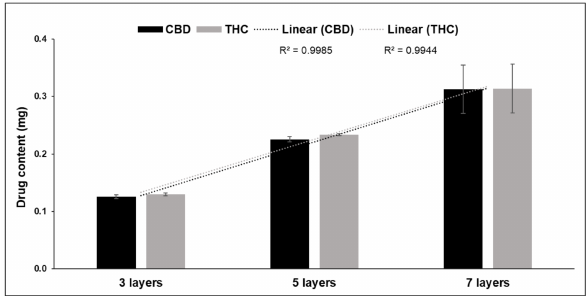
Figure 3. CBD and THC contents of DEEP with three, five and seven imprinted layers. Data are presented as average ± SD ( n =